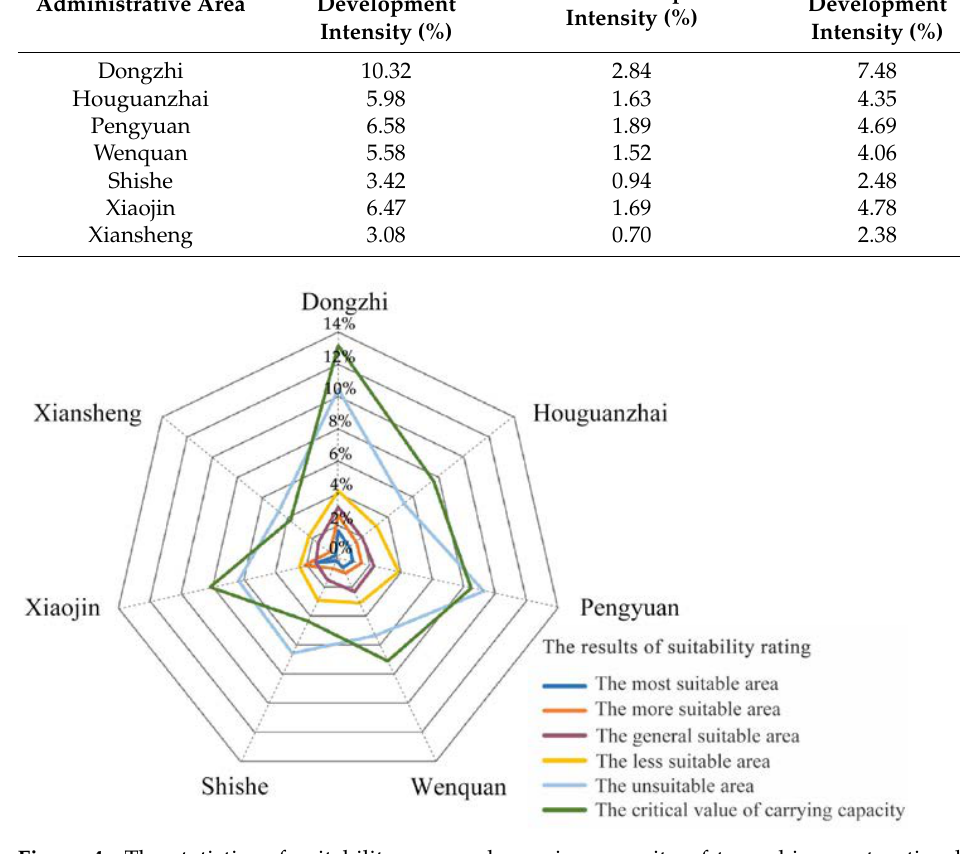
Figure 4. The statistics of suitability area and carrying capacity of township construction land in